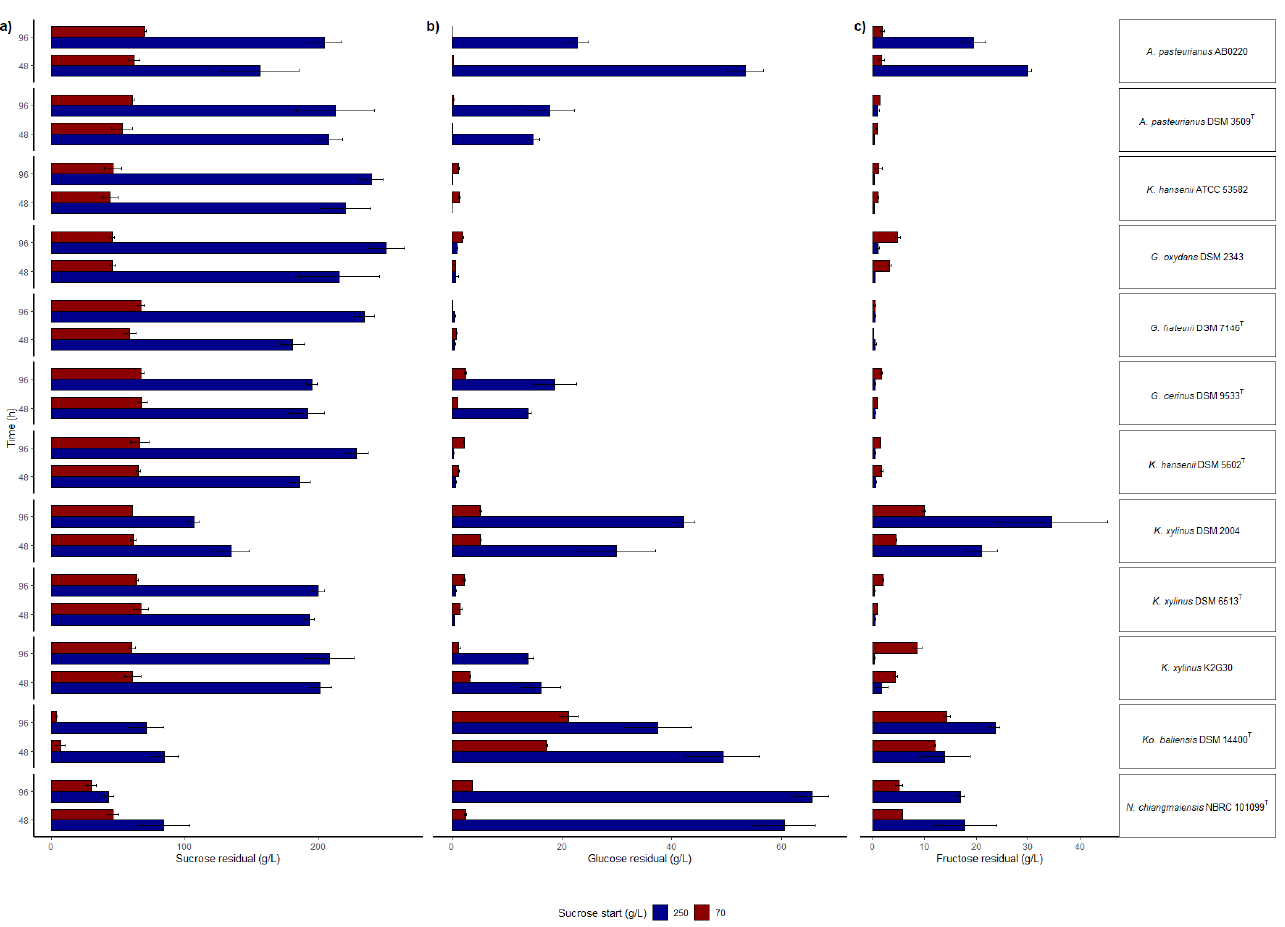
Figure 3. Residual carbon sources, ( a ) sucrose, ( b ) glucose, and ( c ) fructose, in the culture medium at 48 and 96 h of incubation. Bar plot indicates the average consumption by three replicates ± standard error.